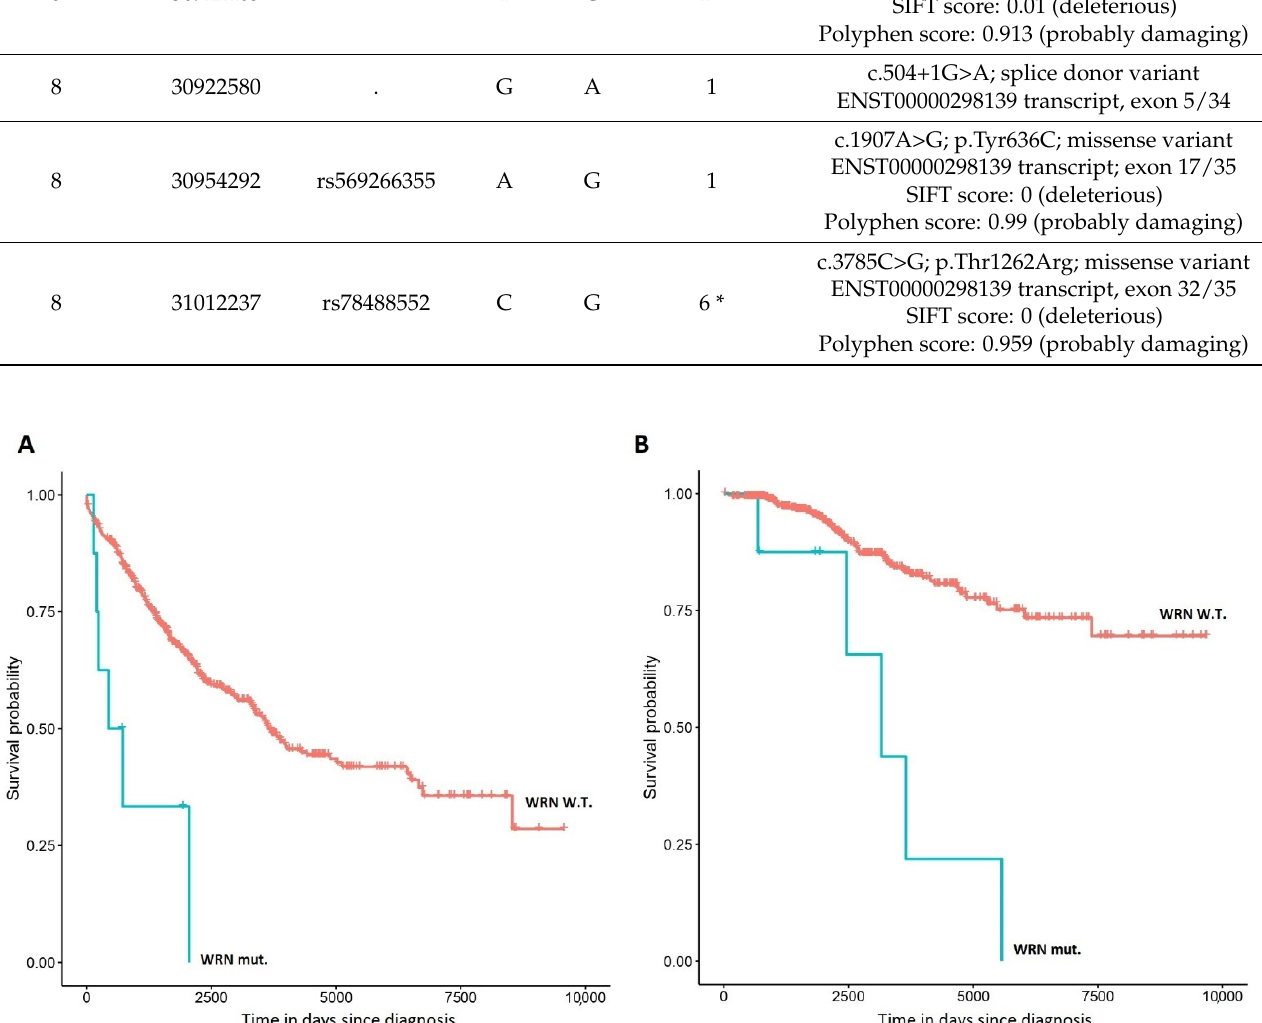
Figure 2. Kaplan–Meier plots representing the association of rare variants in WRN with time to first treatment ( A ) and overall survival ( B ) in chronic lymphocytic leukemia (CLL). Variants considered in this plot are represented in Table 4.